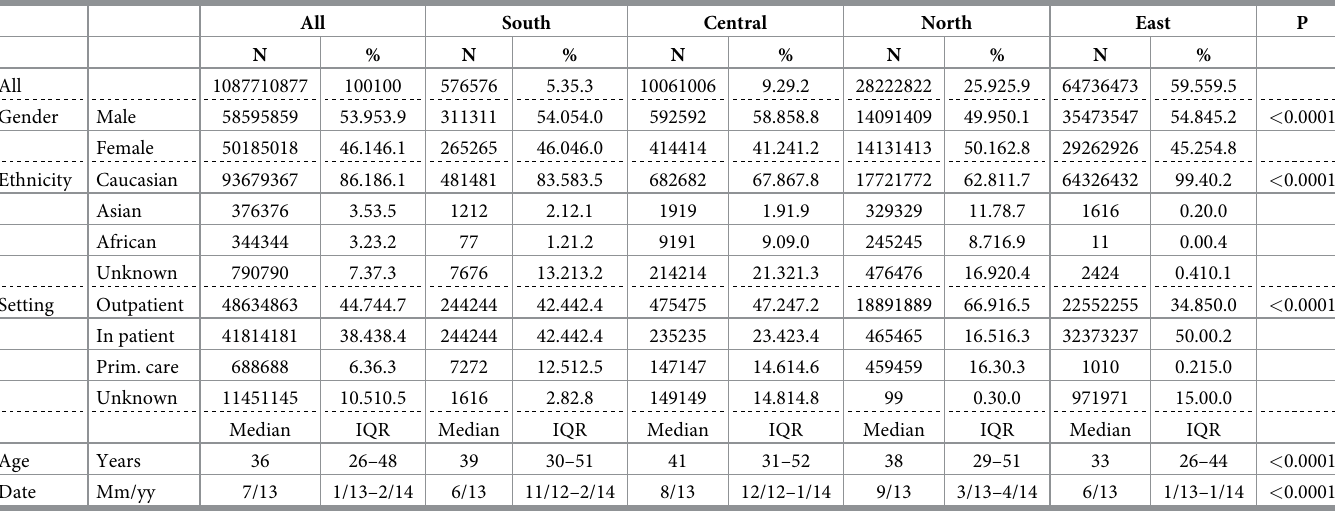
Table 1. Characteristics of included participants stratified by region.